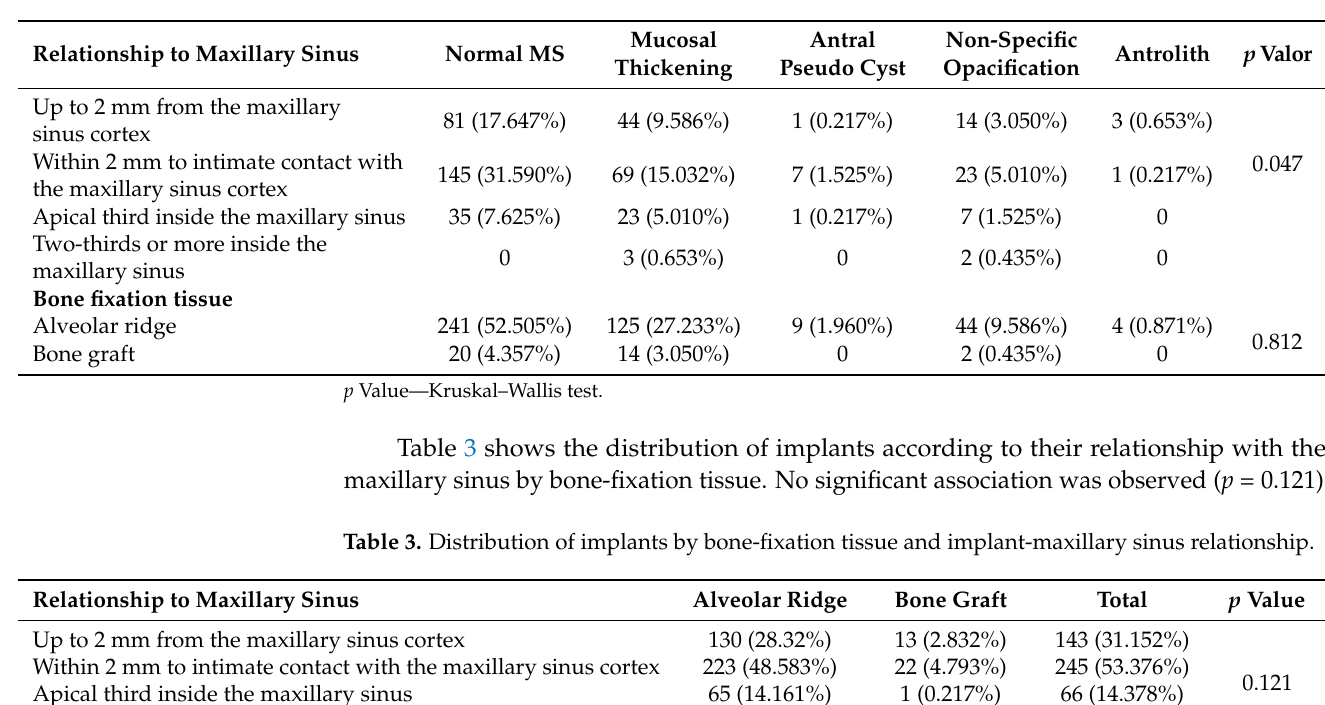
Table 2. Distribution of maxillary sinus abnormalities according to implant-sinus relationship and bone-fixation tissue.